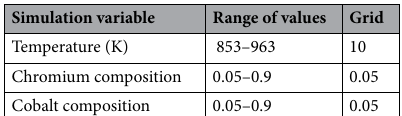
Table 1. Simulation variables and their range of values for database